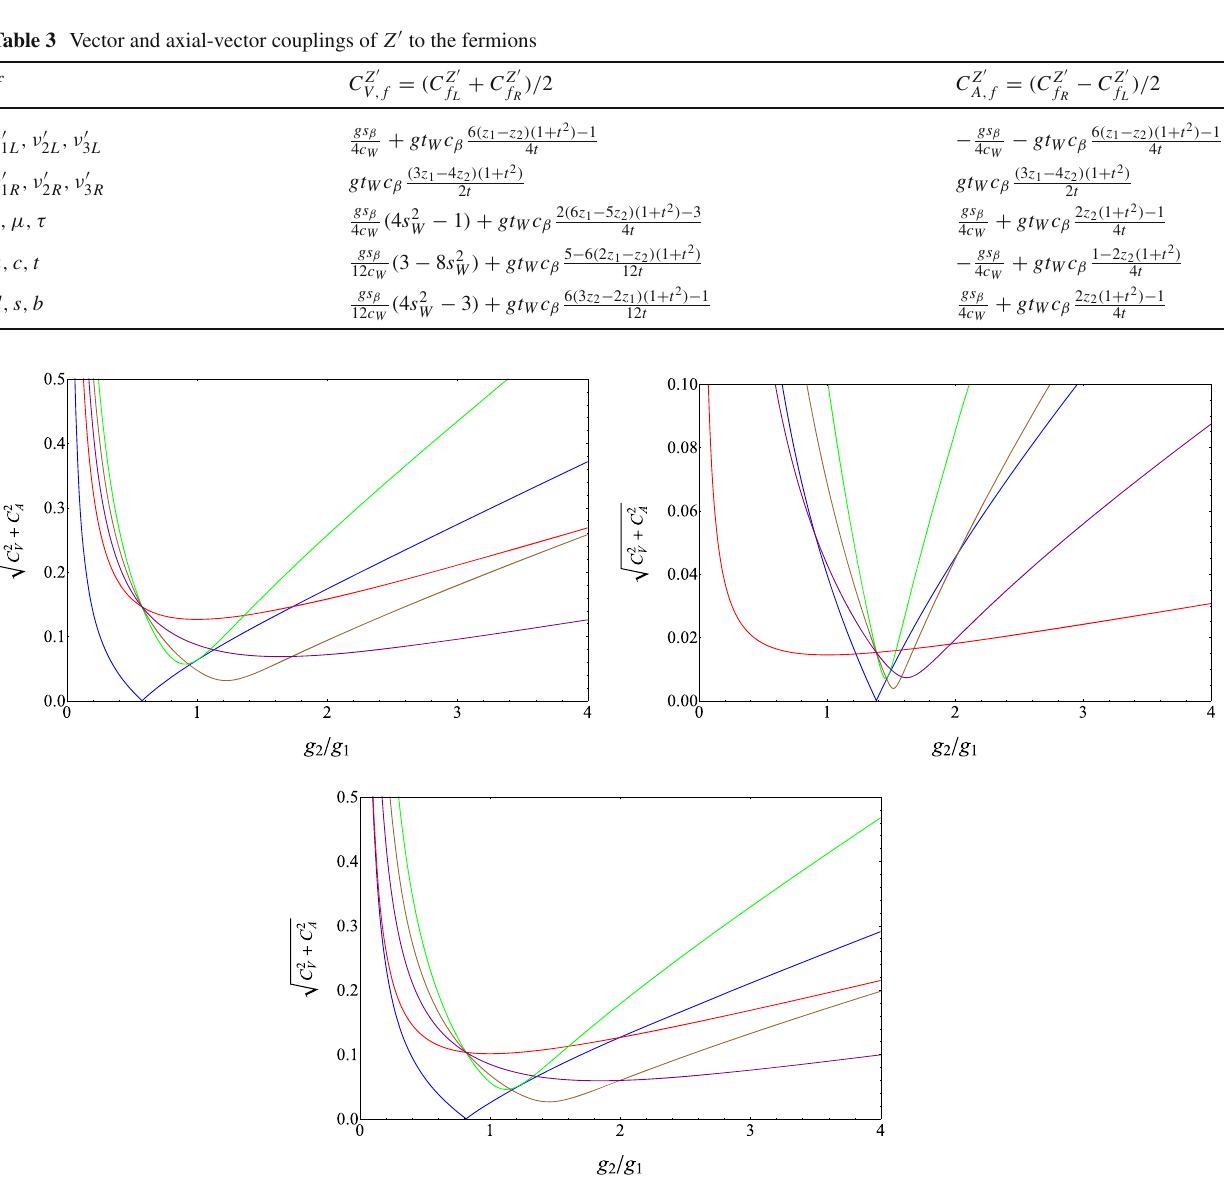
(cid:9) ( C Z (cid:2) ) 2 + ( C Z (cid:2) ) 2 as a function d , respectively. Top-left panel: z 1 = 1 / 4 and z 2 = 1 / 8. Top-right V , f A , f panel: z 1 = 1 / 5 and z 2 = 1 / 7. Bottom panel: z 1 = 1 / 5 and z 2 = 1 / , ν (cid:2) , e , u , and L R